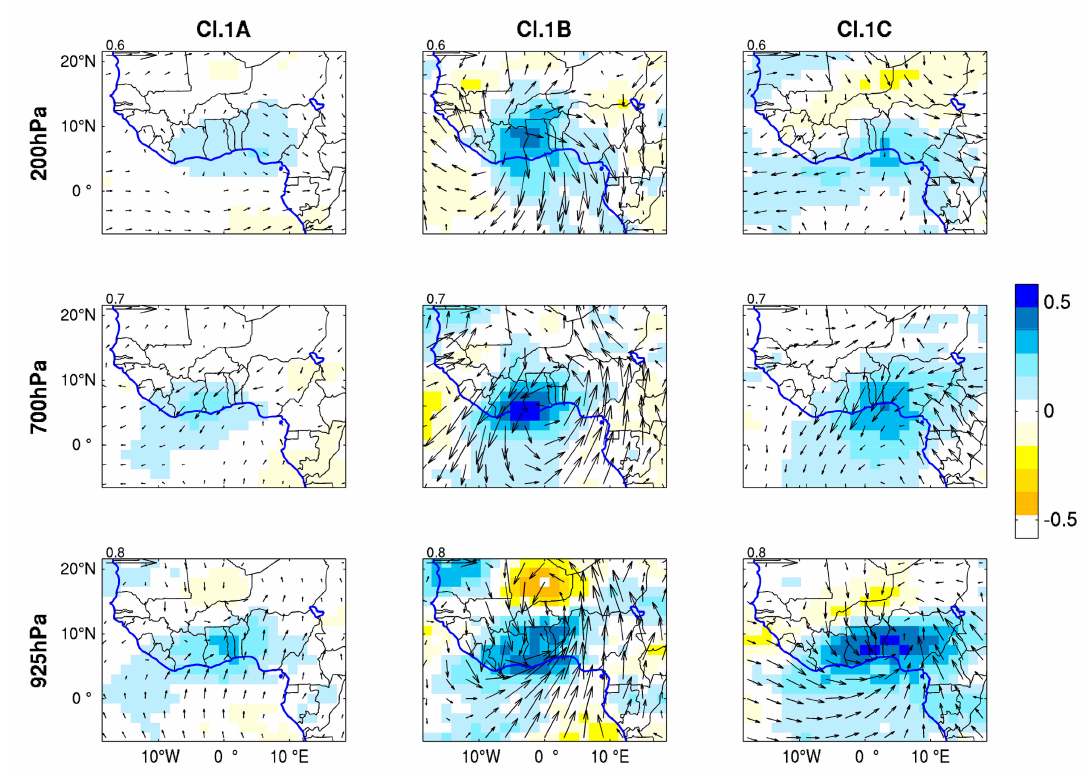
Figure 15. Composite anomalies of wind (vectors) and specific humidity (shadings) associated with rainfall events of clusters 1A, 1B and 1C at the time of the event (day D0). The locations of all events being di ff erent from each other, the composite is based on the average location. Blank: non-significant anomalies (P = 0.999). Units: normalized anomalies on deseasonalised